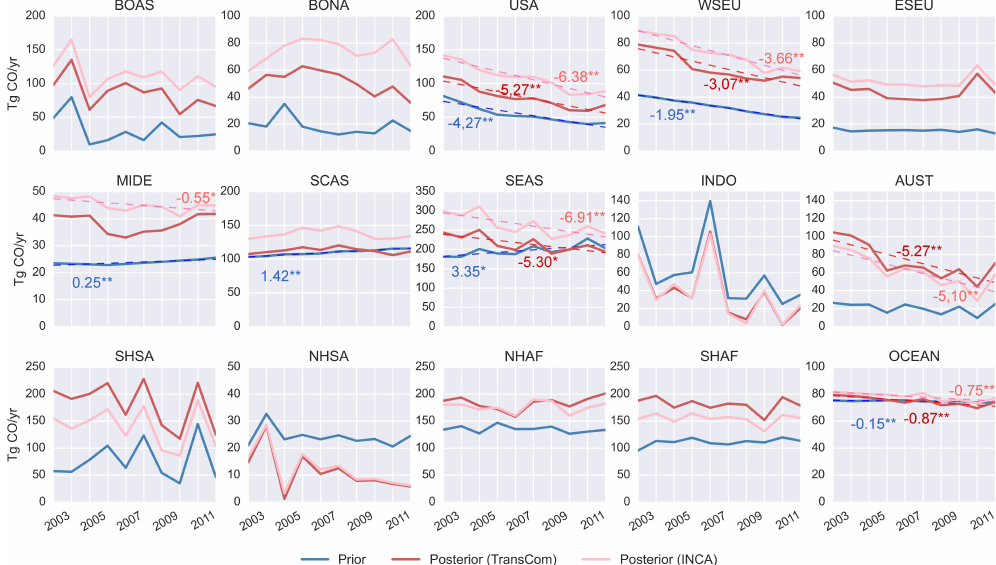
Figure 10. Annual prior (blue) and posterior (red) CO emissions in each sub-region from 2002 to 2011. The dash lines represent linear regressions if the trend is statistically significant. The slopes are denoted beside the linear trends; ∗ and ∗∗ represent significance at the 95 and 99% confidence levels respectively. The notation for the sub-regions is listed as follows and the extent of each region is shown in Fig. A1. BOAS – boreal Asia; BONA – boreal North America; USA – USA; WSEU – western Europe; ESEU – eastern Europe; MIDE – Middle East; SCAS – South–Central Asia; SEAS – South-east Asia; INDO – Indonesia; AUST – Australia; NHSA – Northern Hemisphere South America; SHSA – Southern Hemisphere South America; NHAF – Northern Hemisphere Africa; SHAF – Southern Hemisphere Africa; OCEAN – all ocean emissions, both biogenic and anthropogenic